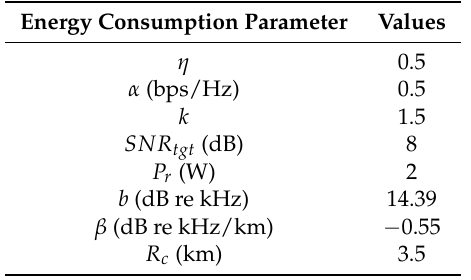
Table 1. Energy Consumption